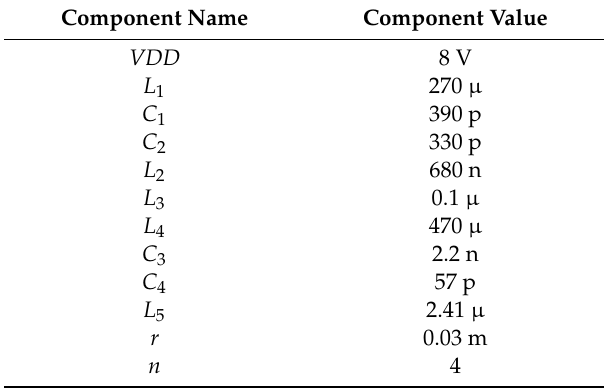
Table 1. Component values for the PA including the inductor.